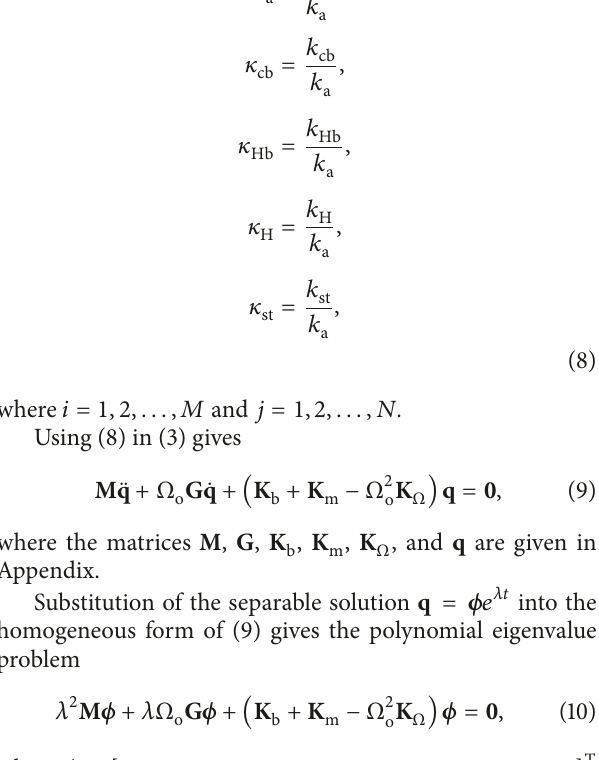
Figure 3: Vibration modes with gyroscopic